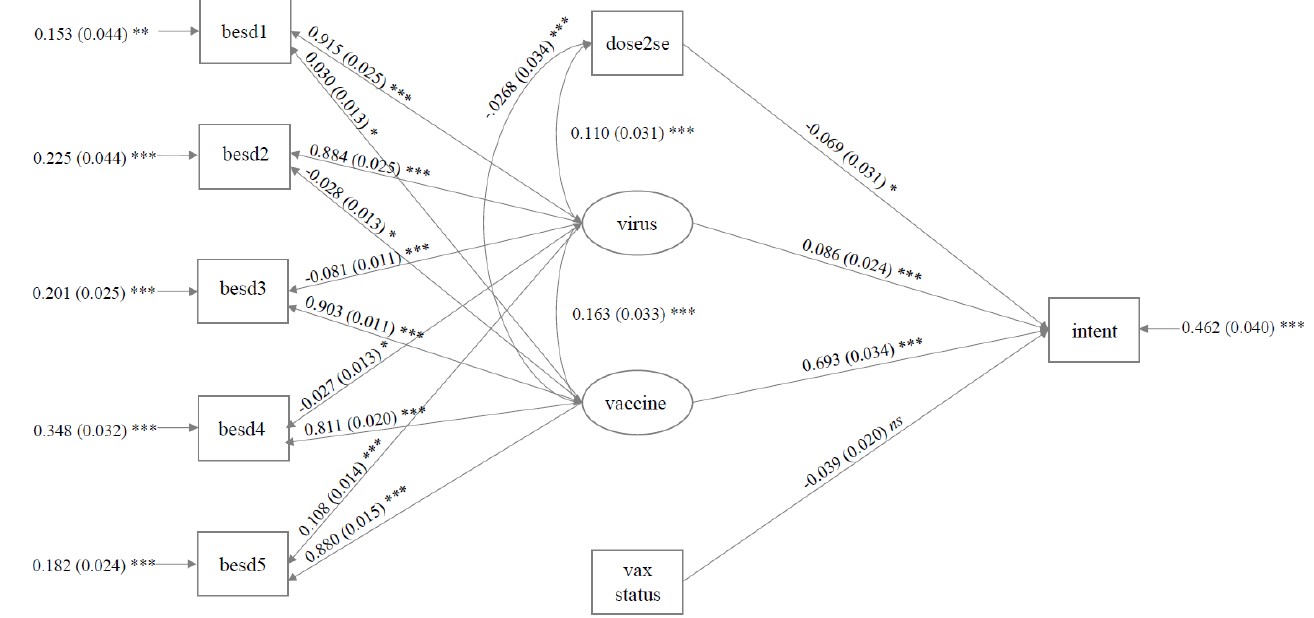
Figure 2. Variables in the final model concerning the UK Sample (statistics are reported as: standardised estimate (standard error) *** ( p < 0.001) ** ( p < 0.01); * ( p < 0.05)). Covariance between latent variables and dose 2 side effects were included to improve fit. The latent variable ‘virus’ relates to psychological perceptions of the COVID-19 virus, and ‘vaccine’ to the COVID-19 vaccine. Other abbreviations are outlined in Table 1 above.